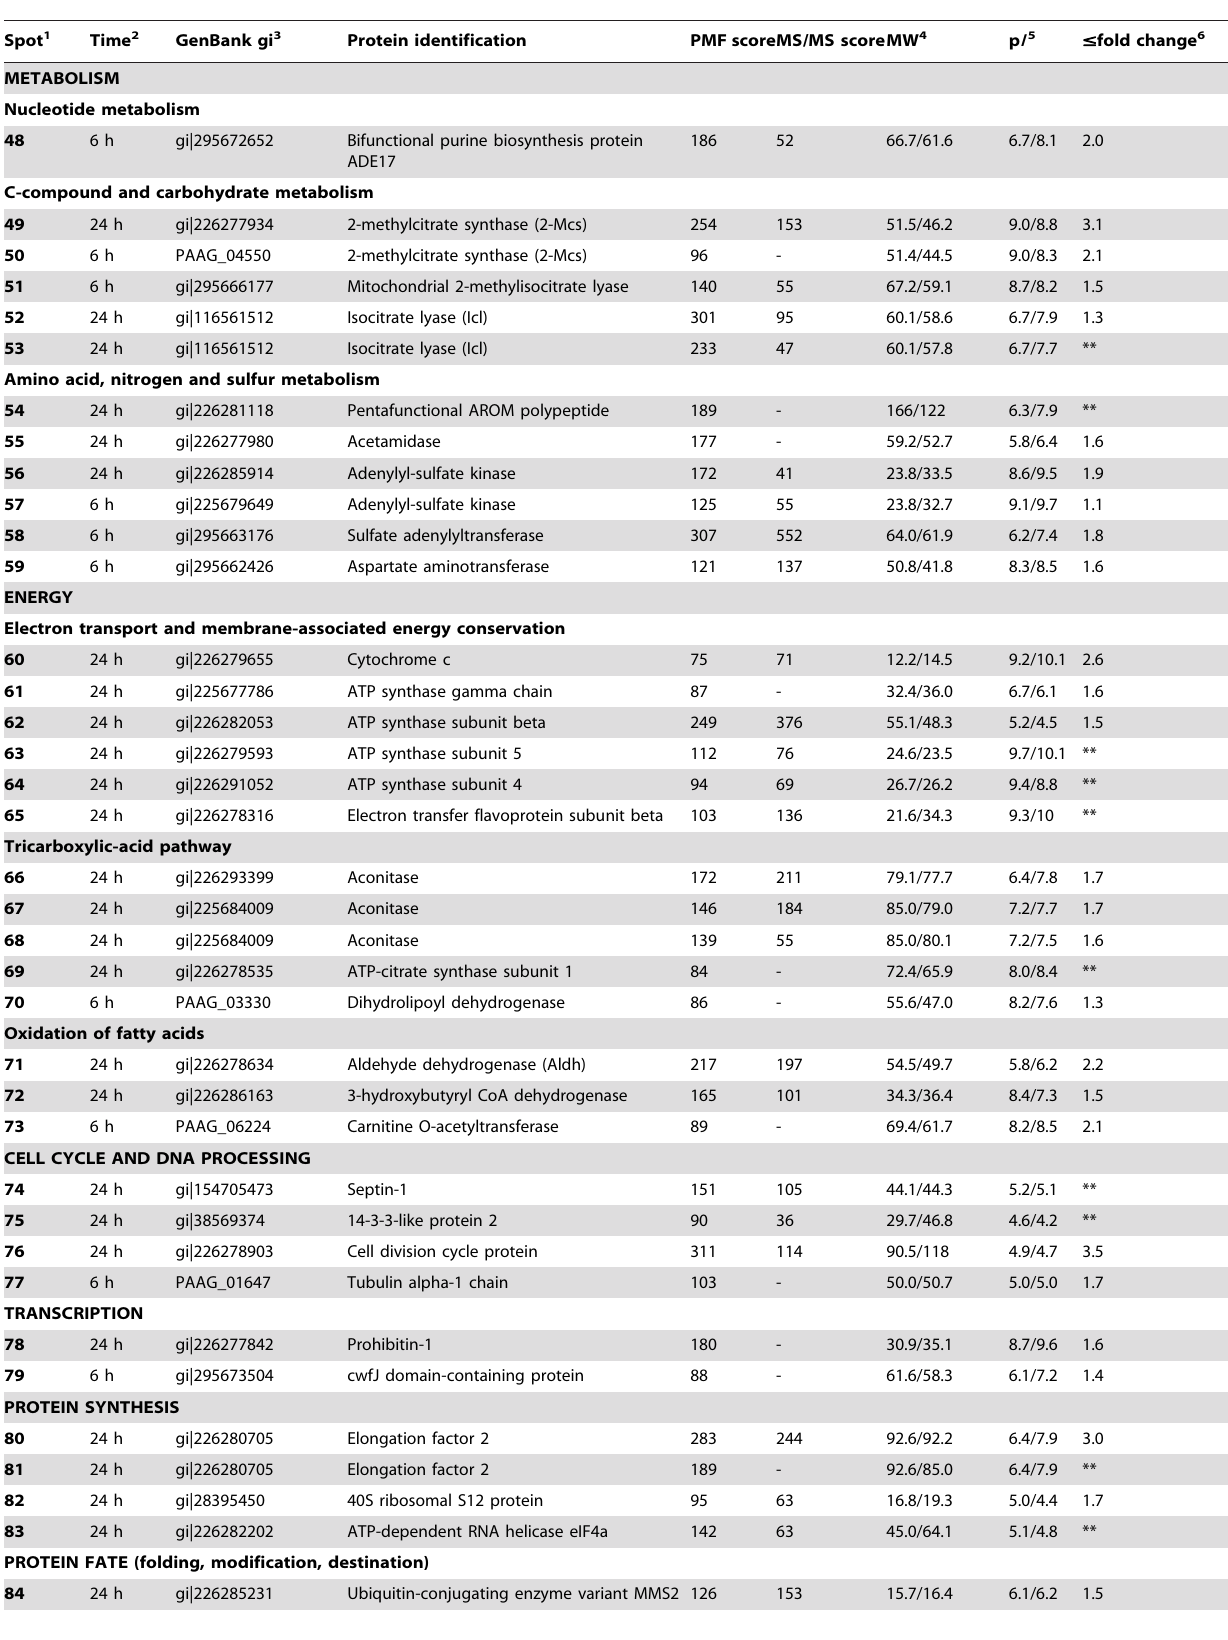
Table 2. P. brasiliensis identified proteins with reduced expression during iron starvation.